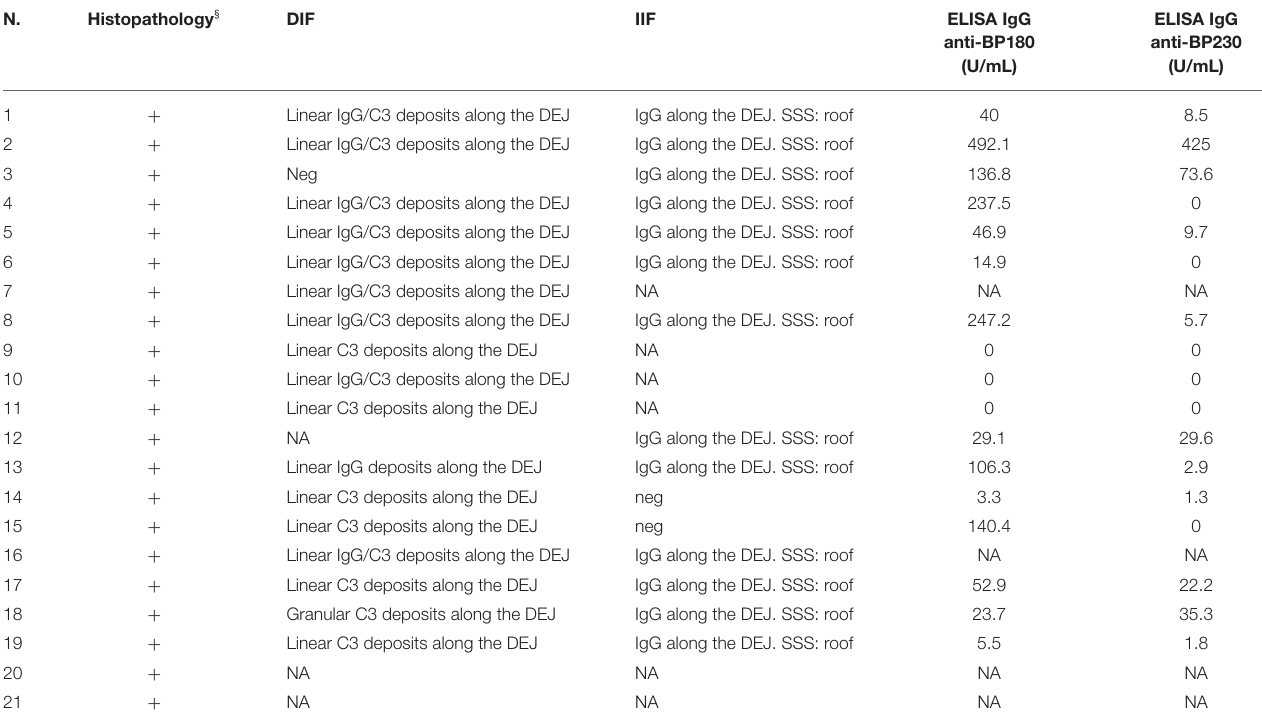
TABLE 2 | Immunopathological features of reported cases.